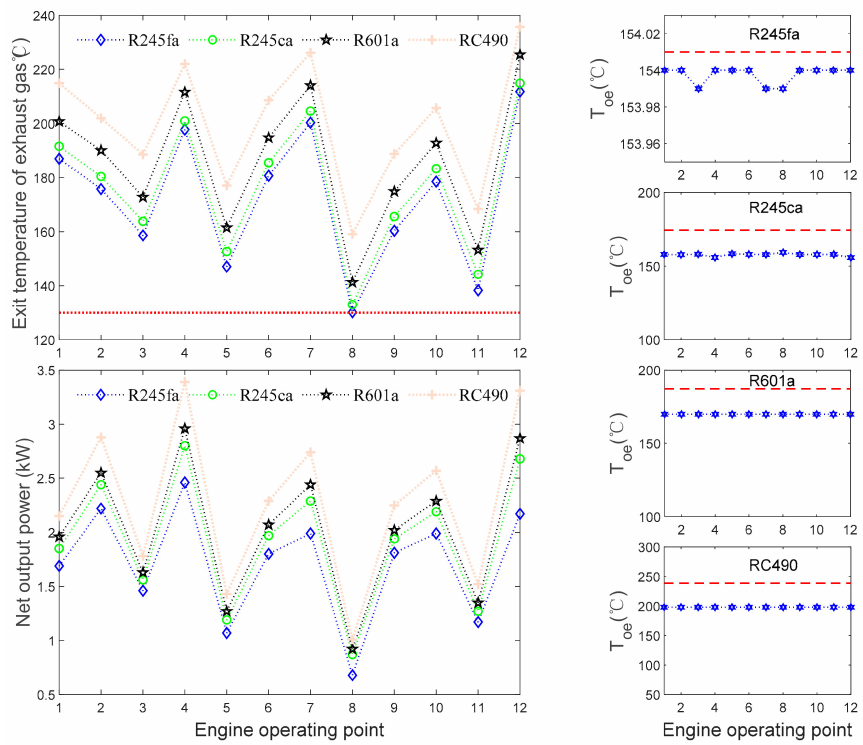
Figure 7. The net output powers and temperature constraints in off-design exhaust conditions.